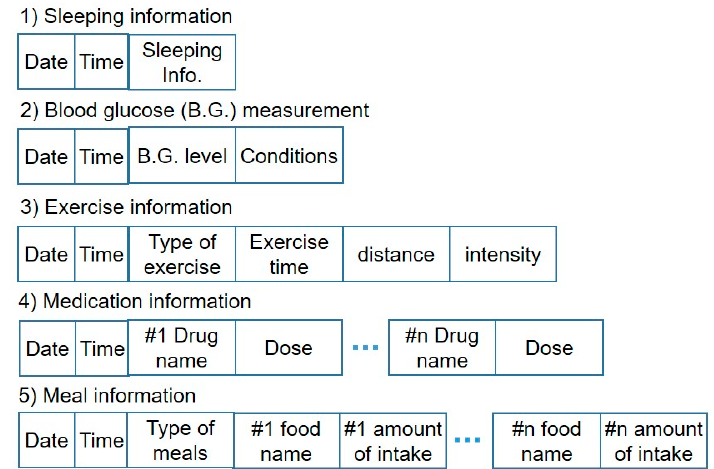
Figure 6. Life-log information related to self-care application.